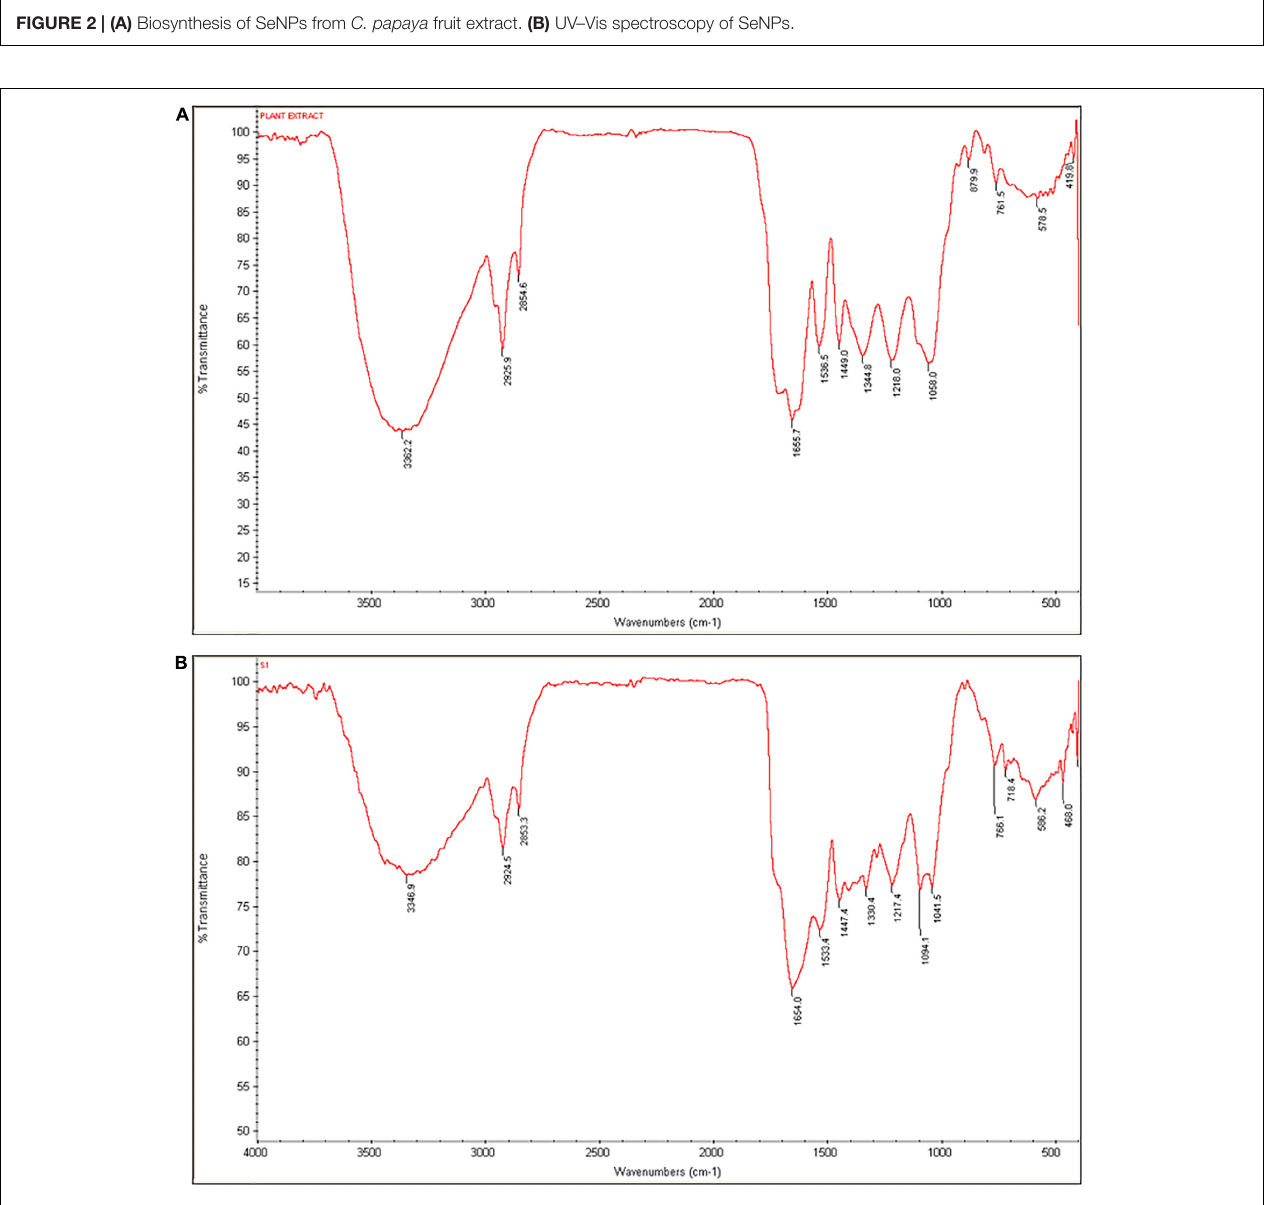
FIGURE 2 | (A) Biosynthesis of SeNPs from C. papaya fruit extract. (B) UV–Vis spectroscopy of SeNPs.